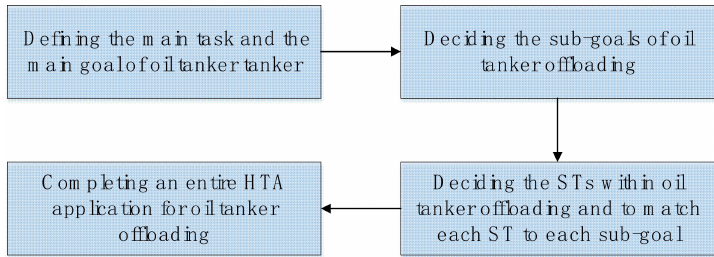
Figure 1. Procedure of HTA for this study.